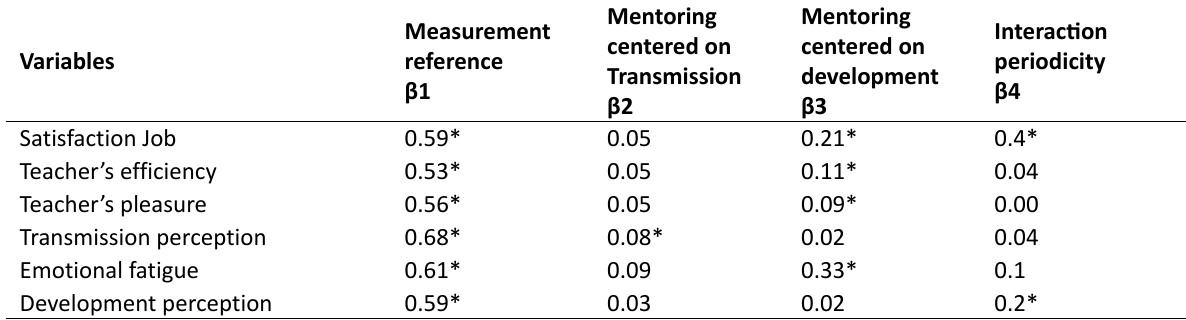
Table 3. Results of structural equation formulas to predict future teachers’ performance (*p < .05.).